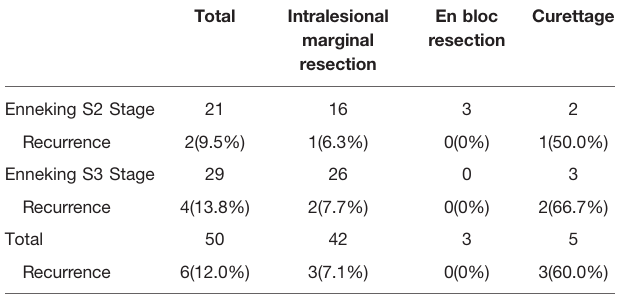
TABLE 2 | Local recurrence